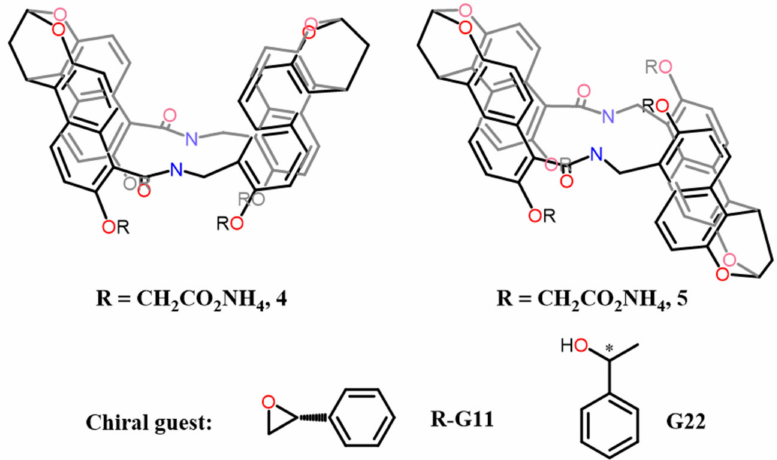
Figure 3. Chemical structure of the chiral guest and naphthalene tubes 4 and 5